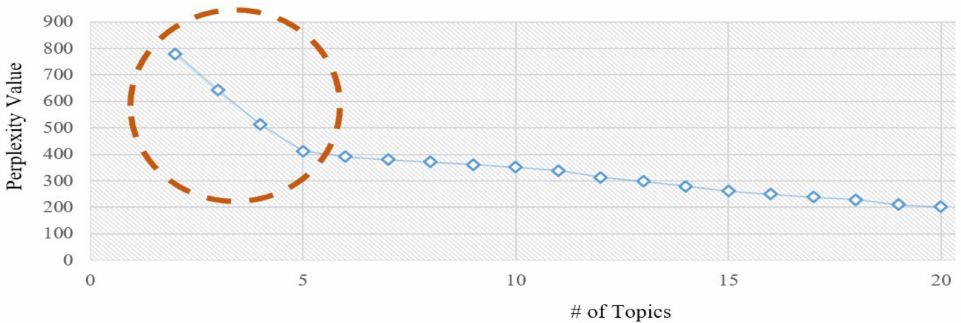
Figure 2. The number of topics determination via